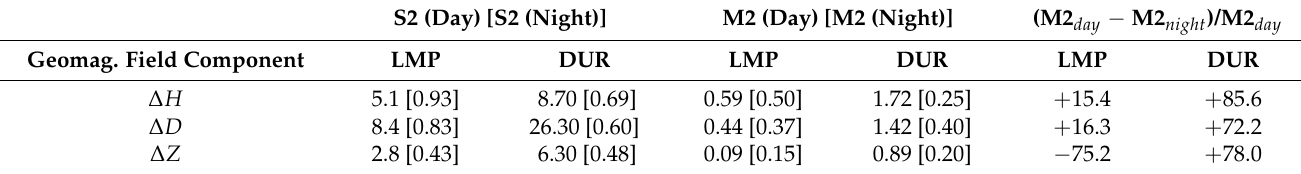
Table 2. Comparison between S2 (columns 2 and 3) and M2 (columns 4 and 5) tidal modes amplitude for daytime and, in square brackets, nighttime hours at LMP and DUR (values are in nT). Columns 6 and 7: relative day–night differences in M2 tidal amplitude in % (see text for details). The results for the three geomagnetic field components H, D and Z are